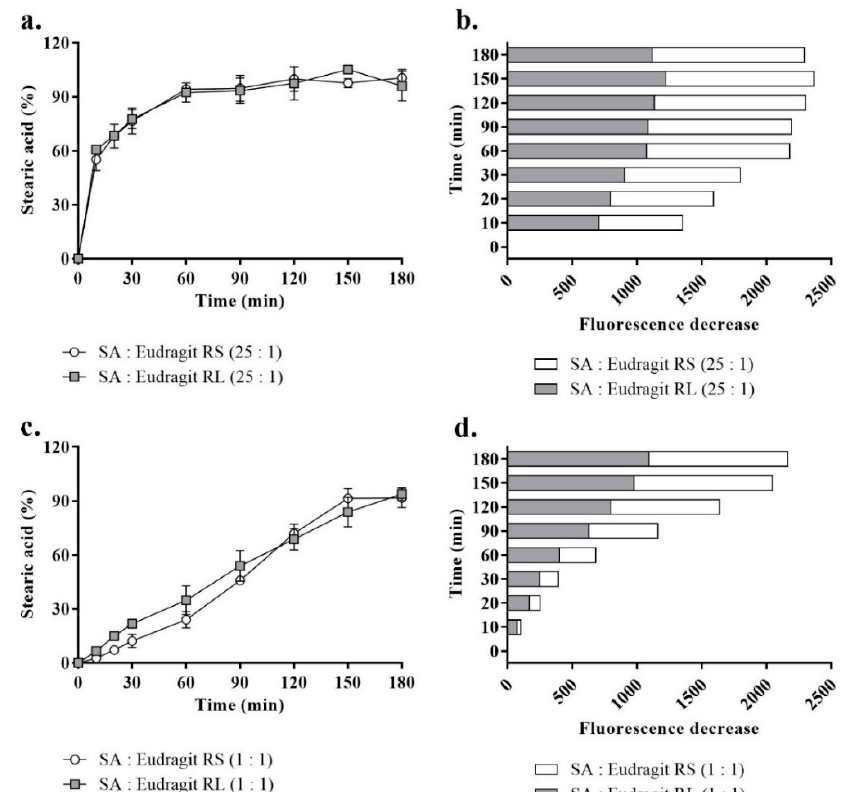
Figure 5. The profiles of SA release from SA-polymer complexes featuring SA-to-polymer ratios of 25:1 with Eudragit RS/RL as a percentage ( a ) and the corresponding fluorescence decrease ( b ) and those of complexes with a SA-to-polymer ratio of 1:1 as a percentage ( c ) and the corresponding fluorescence decrease ( d ) after 1:100 dilution in a release medium of 0.1 mM phosphate buffer (pH 6.8) containing 0.001% fluorescein, taken at 30 min time intervals for 180 min at 37 °C. A 1:1 versus 25:1 SA-to-Eudragit RS/RL ratio led to a significantly greater sustained release of SA ( p ≤ 0.001). Indicated values are the means ± SD ( n ≥ 3).